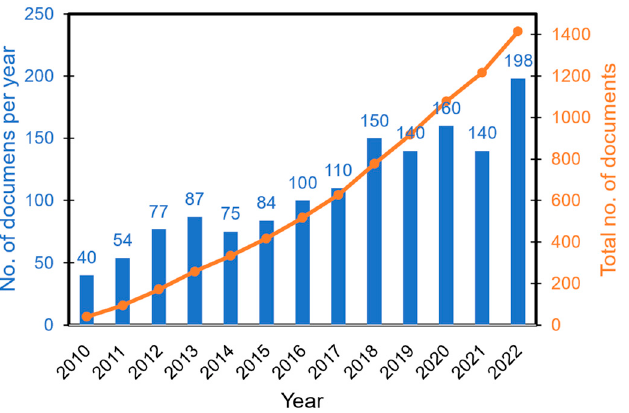
Figure 1. The number of published documents per year and the total number of documents since 2010 according to Google Scholar. The search is done according to the following terms in the title: “magnetoactive elastomer” OR “magnetoactive elastomers” OR “magnetoactive polymer” OR “magnetoactive polymers” OR “magnetorheological elastomer” OR “magnetorheological elastomers”. The results for the year 2022 are linearly extrapolated from the available data on 15 September 2022.